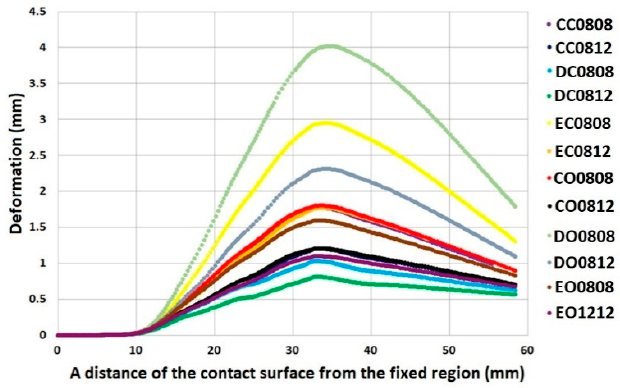
Figure 12. Deformation of the contact side for structures C, D, and E under load 5 N.